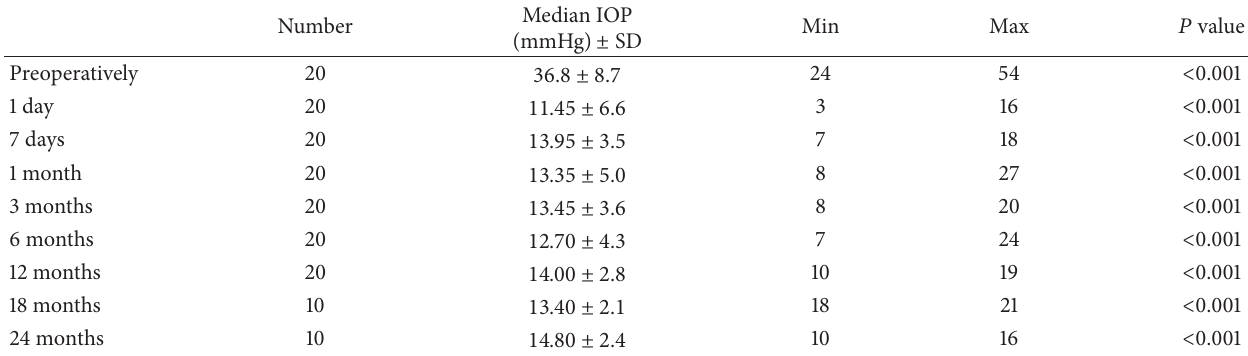
Table 1: Statistical significance of postoperative intraocular pressure